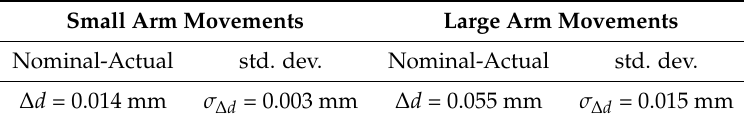
Table 1. Target-performance comparison of two measuring series of a gauge block using small and large arm movements. The values describe the average and standard deviation (std. dev.) of the 10 measuring series, resulting in more than 1500 distance